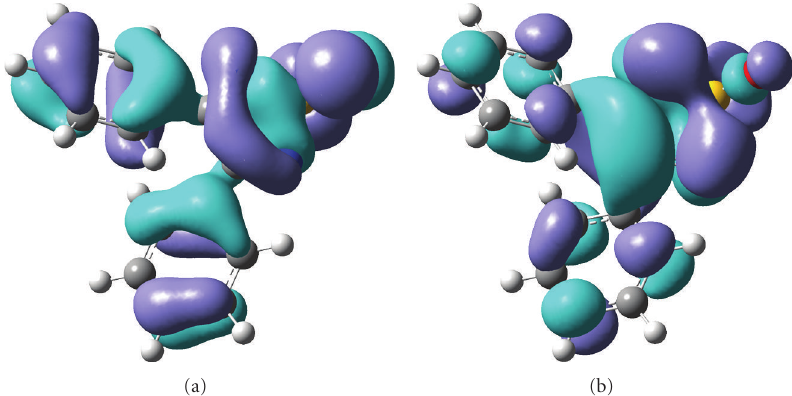
Figure 4: HOMO and LUMO of the TSO molecule calculated with the CHIH-DFT model chemistry.